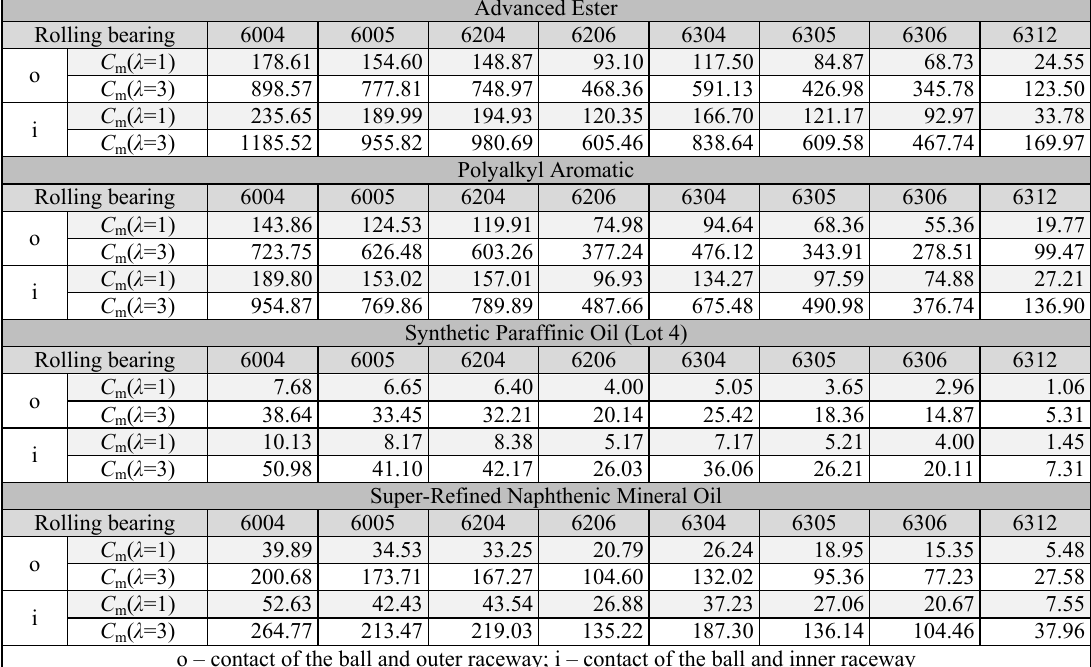
Table 2. Regime lubrication coefficient C m ( λ ) values for four oil lubricants and eight radial ball bearings, with contact surfaces roughness of R ar =0.14 μ m and R ab =0.05 μ m and operating temperature of 38°C